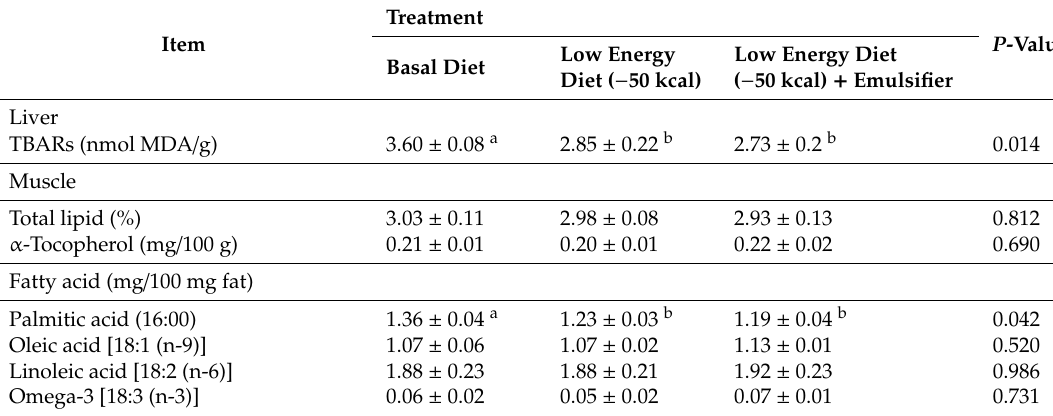
Table 4. E ff ect of test diets on liver thiobarbituric acid retroactive substances (TBARs), muscle total lipid, α -tocopherol, and fatty acid profile contents in